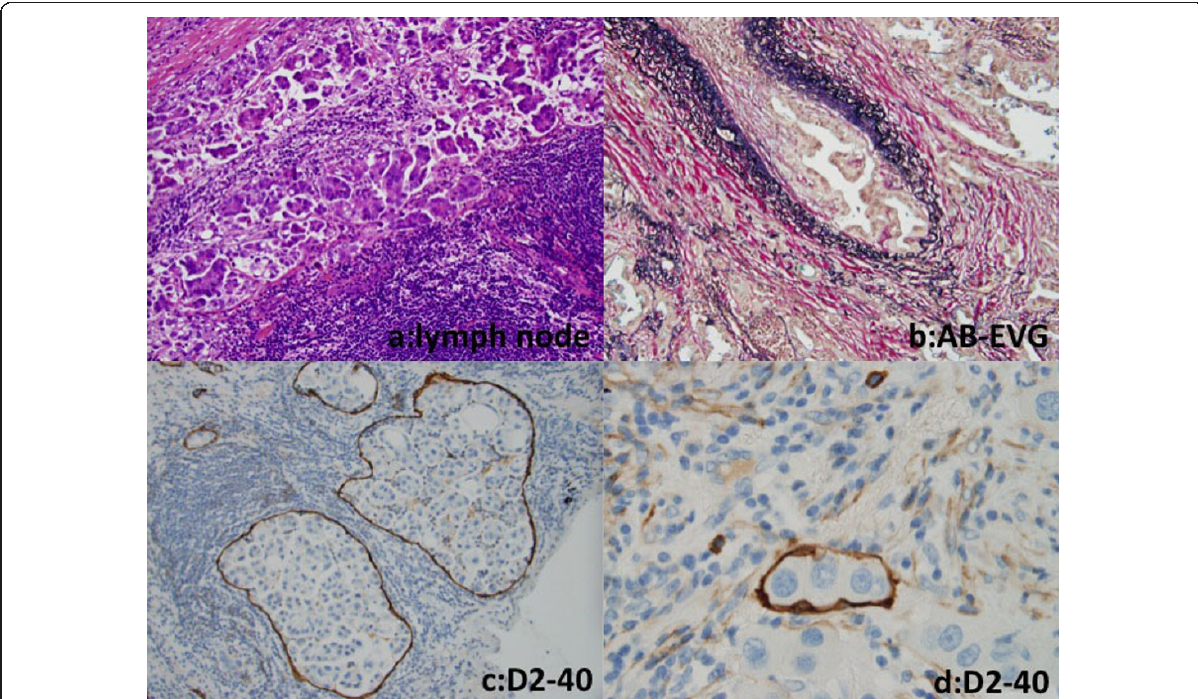
Figure 4 Photomicrographs . (a) A resected regional lymph node had metastatic foci composed of tumor cells with a micropapillary pattern in the case 1. (HE stain, ×200) (b) Vessel invasion by tumor cells in the case 1. (AB-EVG stain, ×100) (c, d) Tumor cells in lymphatic ducts, which